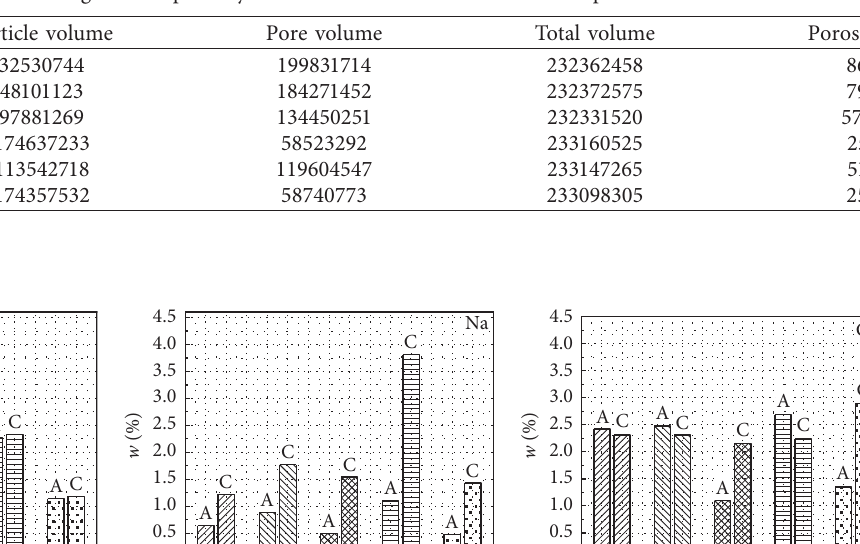
Table 3: Change in soil porosity before and after the electro-osmosis